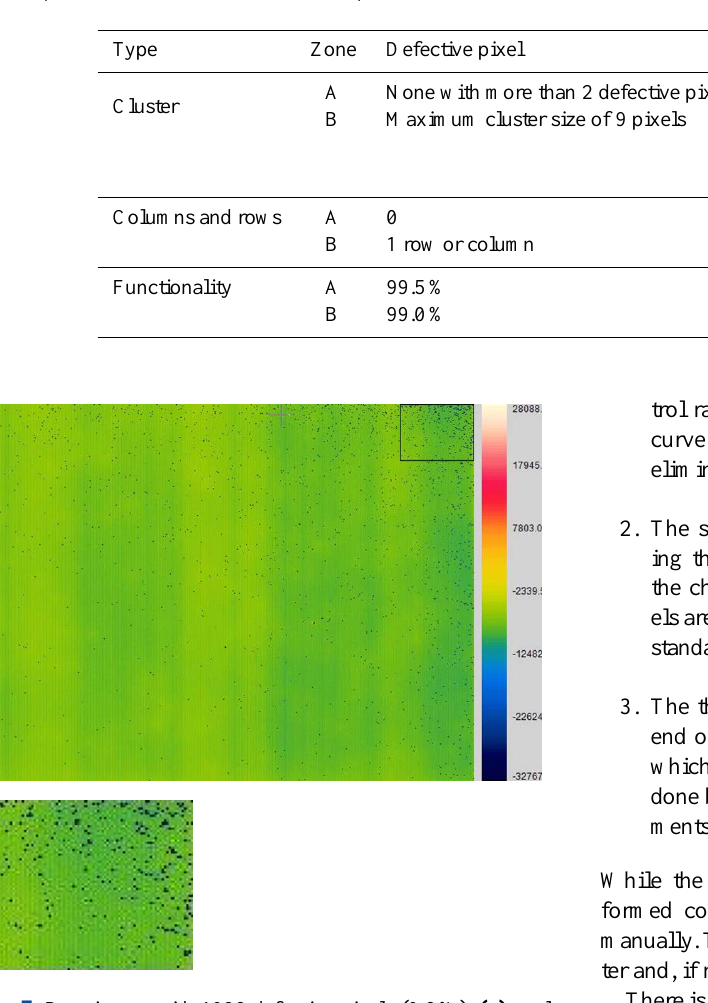
Figure 7. Raw image with 1926 defective pixels (0.6%): (a) total microbolometer array and (b) the section marked in the top right- hand corner (90 × 70 pixels). Defective pixels are shown in black. Microbolometer array with 640 × 480